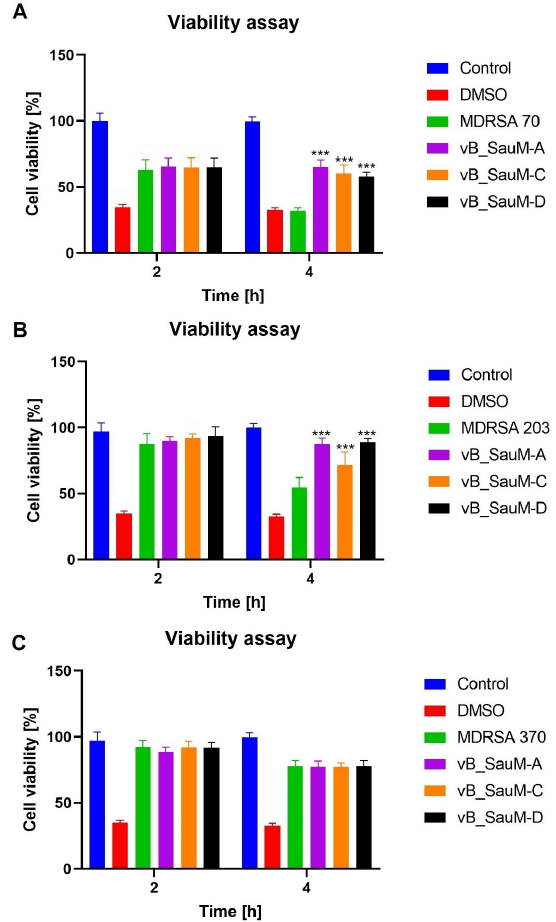
Figure 5. Cell viability of the BJ cells infected with MDRSA strains 70 ( A ), 203 ( B ) and 370 ( C ) treated with phages vB_SauM-A, vB_SauM-C and vB_SauM-D after 2 and 4 h of incubation in comparison to the phage-untreated control (green). Negative control (blue) and 10% DMSO-treated positive con- trol (red) are visualized as referent values. Mean values from three independent experiments are shown, with error bars representing SD. Statistical analysis was performed using the Kruskal–Wallis test followed by Dunn’s multiple comparison test for values with nonparametric distribution, with *** p <